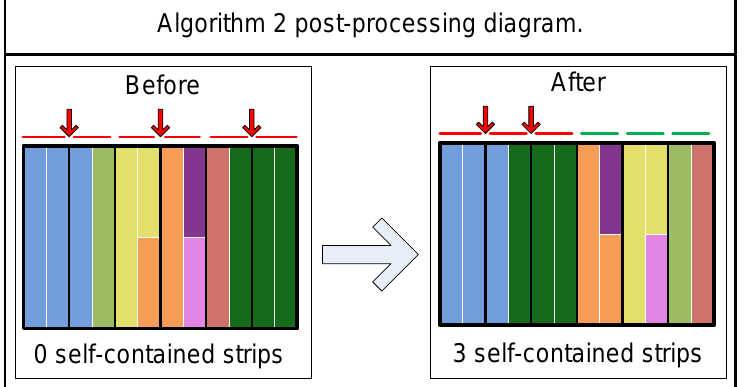
Figure 6. Diagram of post-processing applied to A2. Before processing there is no available strips to exchange (highlighted in red). However, after processing 3 strips are now self-contained and can be moved out (highlighted in